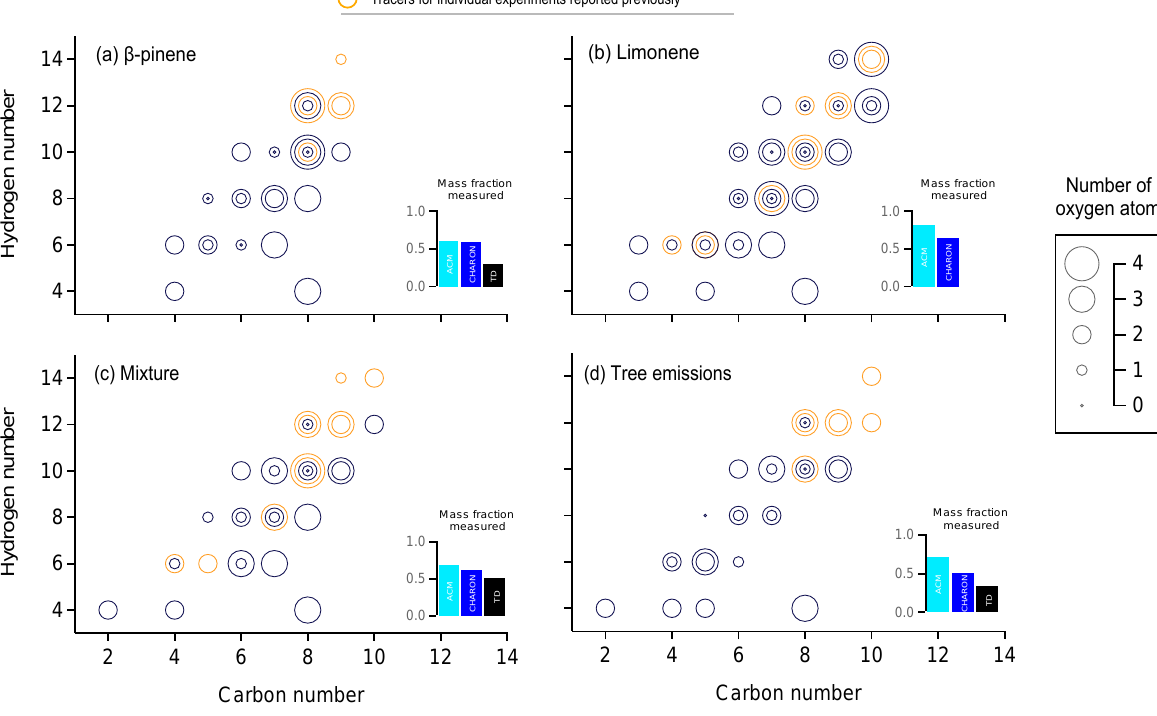
Figure 7. Chemical formula attribution based on the molecular carbon number ( x axis), hydrogen number ( y axis) and oxygen number (markers size) for (a) the ozonolysis of β -pinene, (b) ozonolysis and NO 3 oxidation of limonene, (c) ozonolysis of the β -pinene–limonene mixture and (d) ozonolysis of real tree emissions (Scots pine). Markers correspond to compounds measured from all techniques (ACM, CHARON and TD) at high concentrations (within the 80 compounds observing highest concentration). Each circle corresponds to one compound. Orange markers indicate tracer compounds supported from previous publications (for details refer to Table S1). Bars indicate the fraction of mass explained when accounting only for the presented compounds, for each instrument (ACM: light blue; CHARON 100 : blue; and TD: black) based on their total aerosol mass